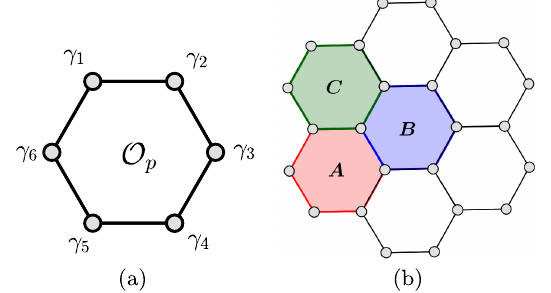
operator is the p